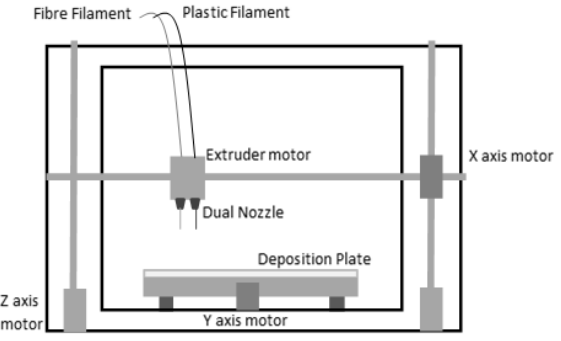
Figure 1. Markforged dual extruder deposition system.